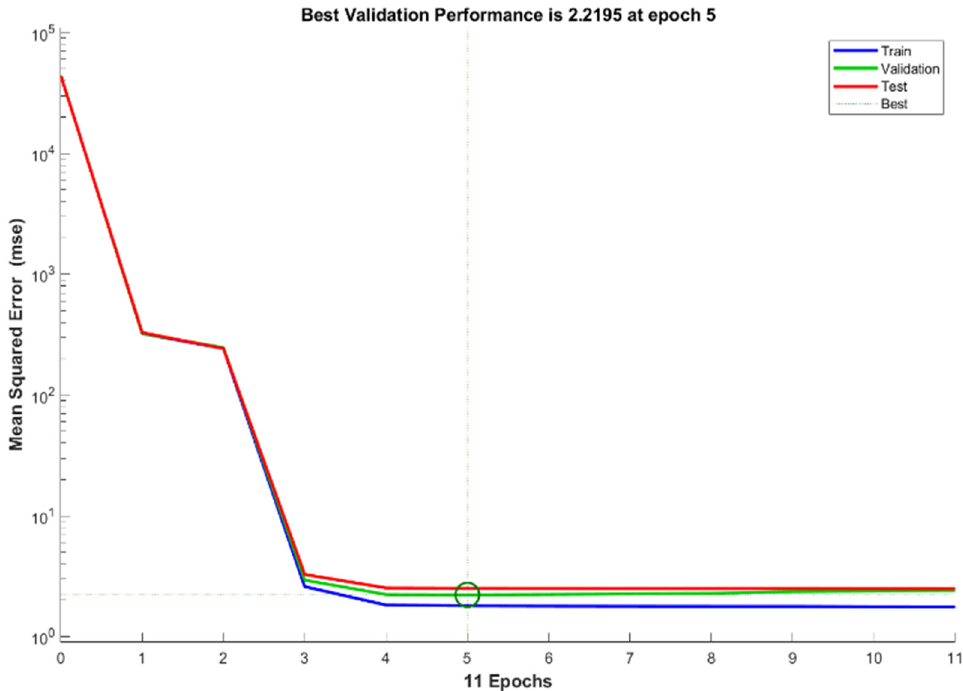
Figure 7. Performance of best validation at Epoch 5, which shows reduced and maintained errors .